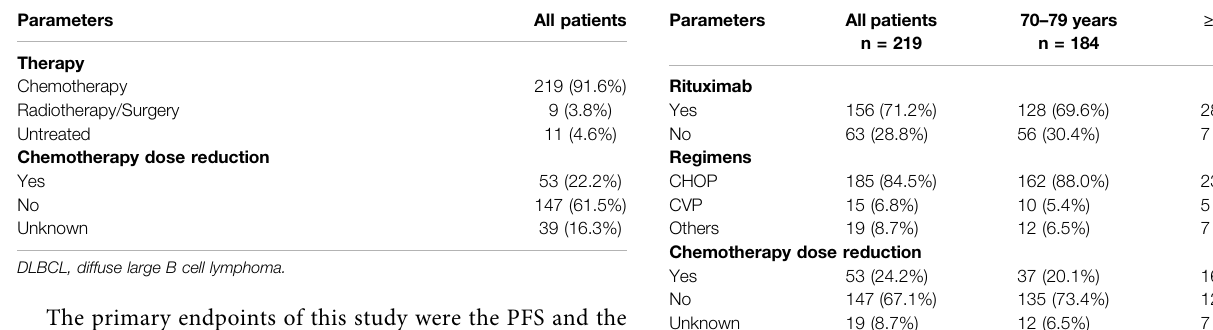
TABLE 3 | Chemotherapy regimens adopted in patients with DLBCL (n=219).